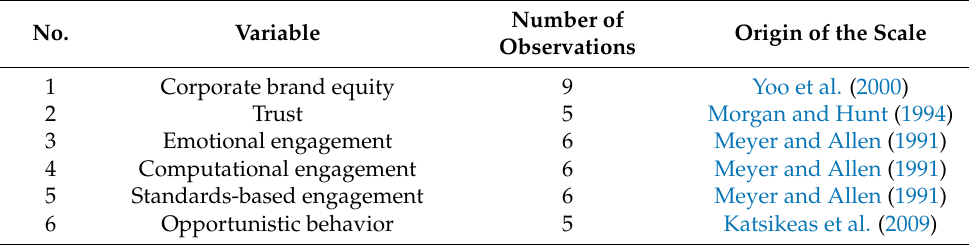
Table 1. The origin of the scale of